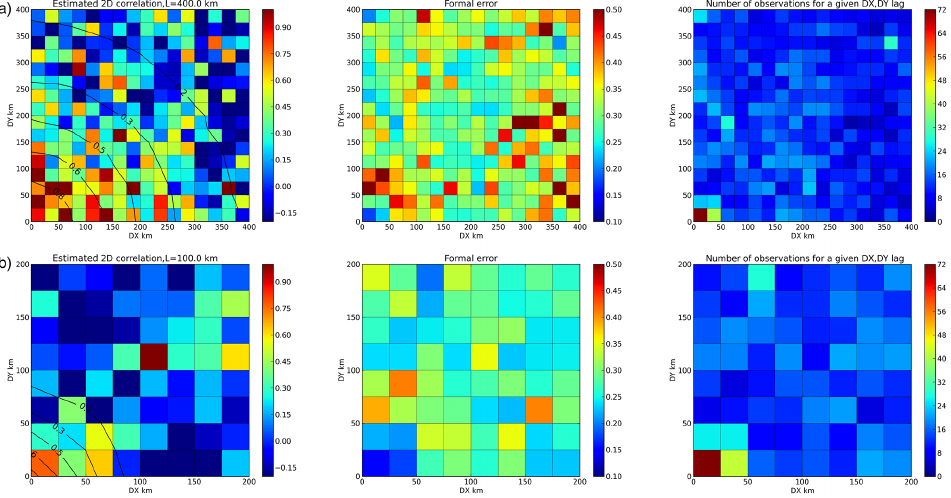
Figure 2. (a) Estimated 2-D covariance fields for the L = 400km simulation for the 2005 Argo sampling (left), associated formal errors (middle) and number of observation pairs (right). (b) Estimated 2-D covariance fields for the L = 400km simulation for the 2013 Argo sampling (left), associated formal errors (middle) and number of observation pairs (right). Black isolines (left) correspond to the adjusted covariance